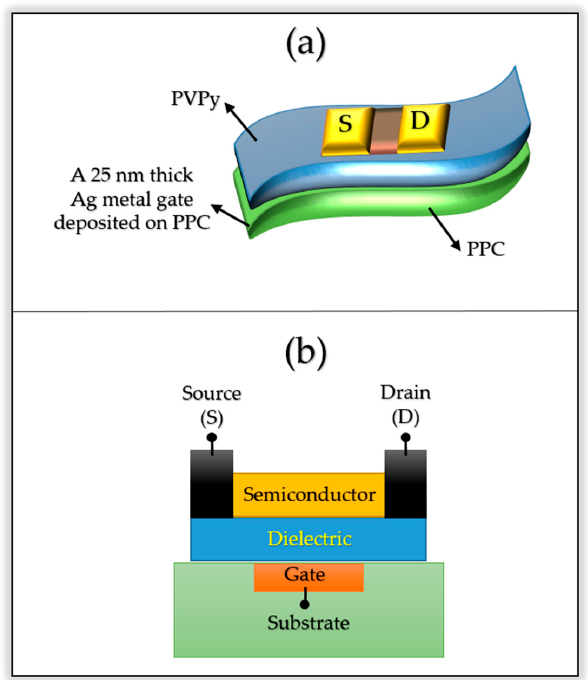
Figure 3. Pictograph representing ( a ) the bottom-gate top-contact organic thin film transistor (OTFT) on the polypropylene carbonate (PPC) substrate, and ( b ) a typical design of OTFTs. Adapted with permission from [80], Springer Nature, 2018.